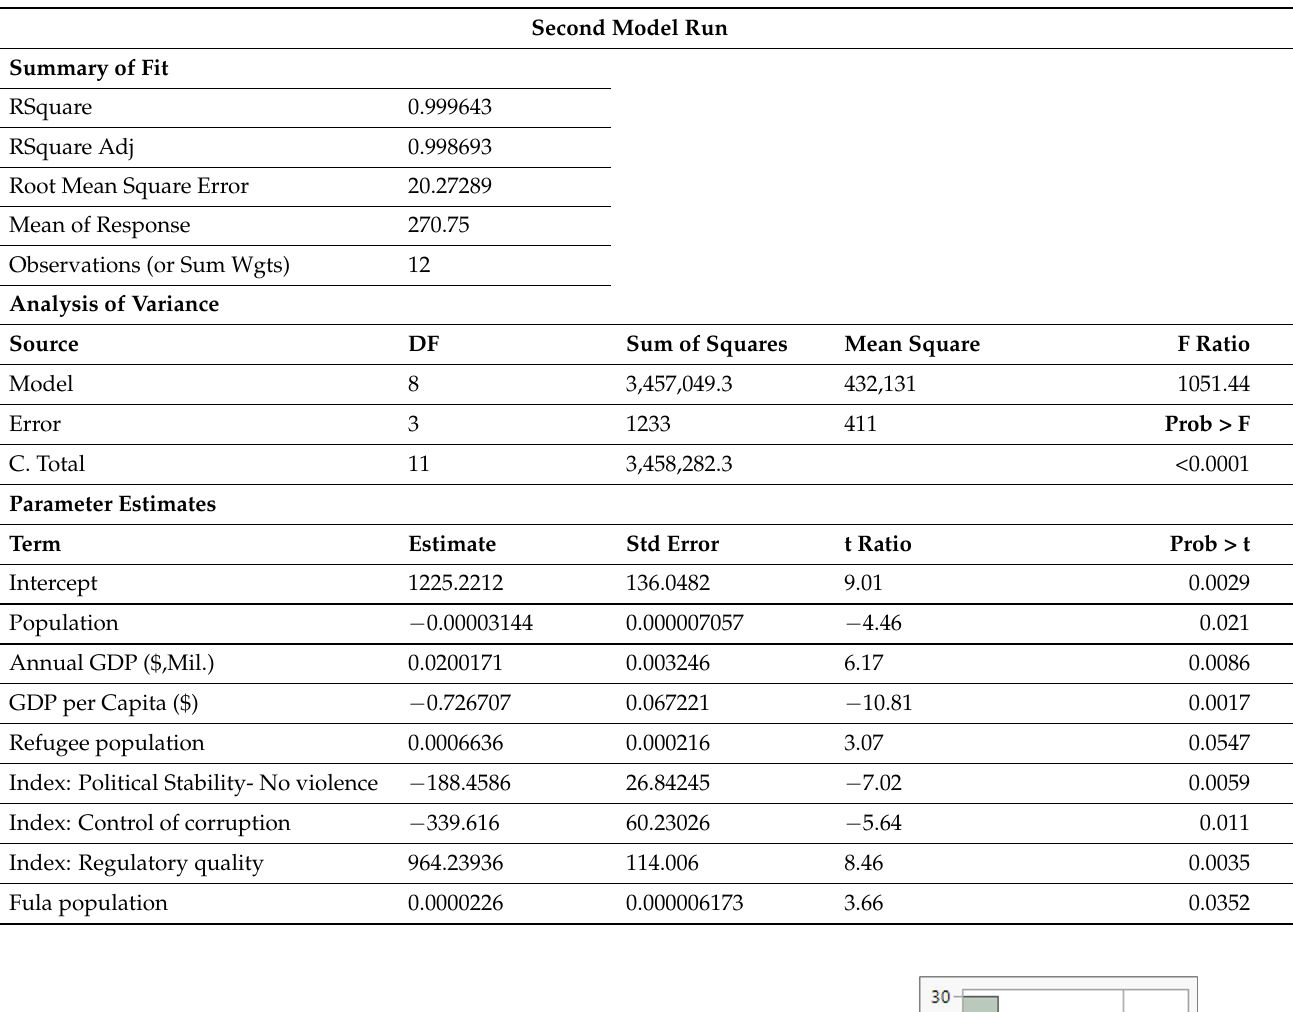
Table 8. Fitting the multiple regression model with a backward selection of covariates—the second model run, after removing the covariate Geographic size .